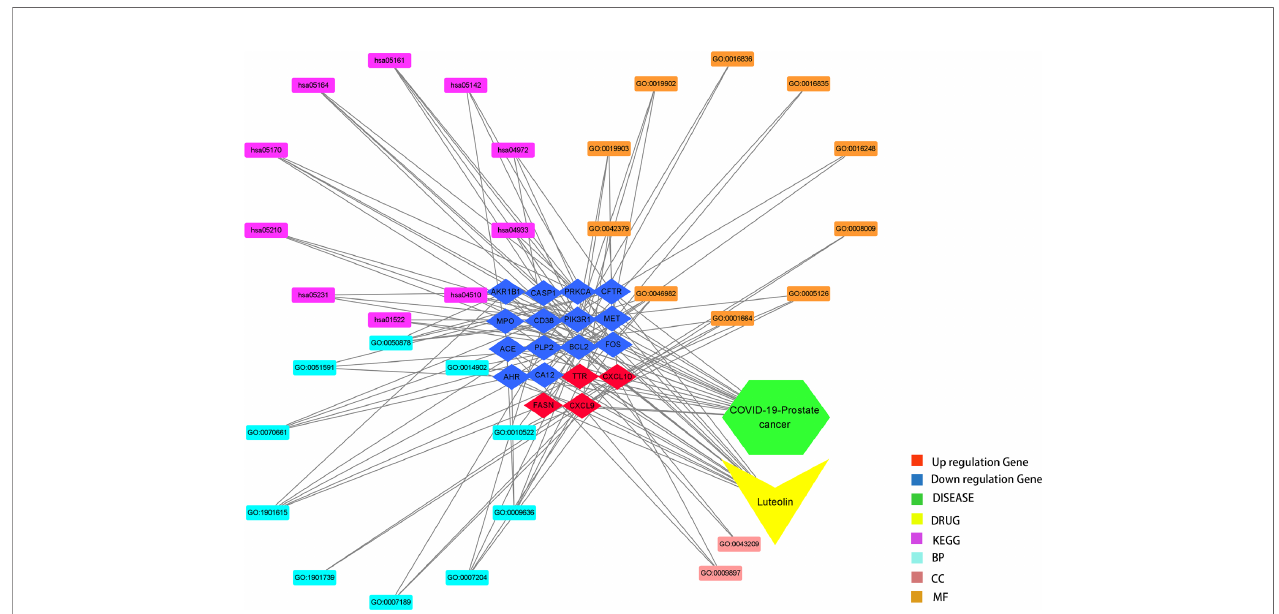
FIGURE 6 | Composite graph of luteolin targeting genes – enrichment pathways – PC/COVID-19.